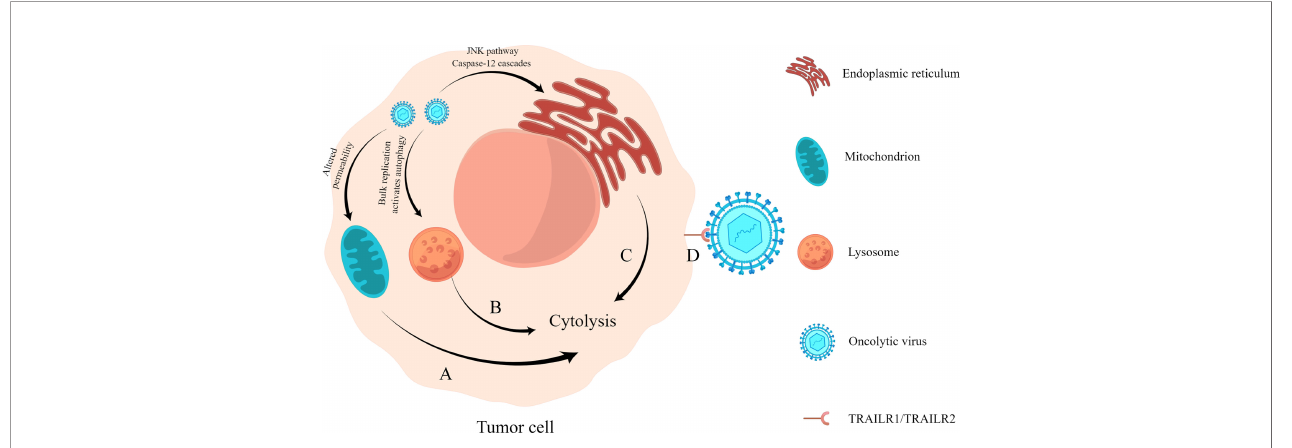
FIGURE 1 | Direct oncolysis. (A) Oncolytic virus acts on the mitochondria of tumor cells, resulting in the loss of mitochondrial permeability, resulting in abnormal cell metabolism and death. (B) Oncolytic viruses replicate abundantly and cause lysosomes to become damaged, triggering cell lysis (Yang et al., 2021). (C) Oncolytic virus infection causes endoplasmic reticulum stress response and cell lysis by activating the JNK pathway and caspase-12 cascades. (D) Virus surface capsid protein binds to TRAILR1 or TRAILR2 and causes apoptosis through the molecular mechanism of trail-mediated